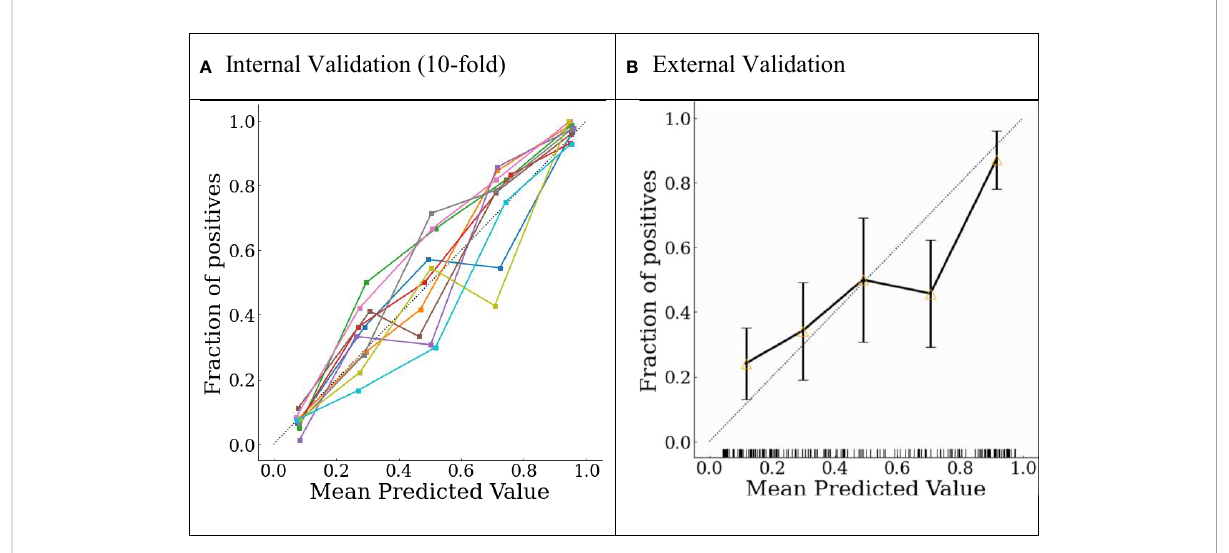
FIGURE 5 Probability calibration plots for (A) internal 10-fold cross-validation and (B) external validation.